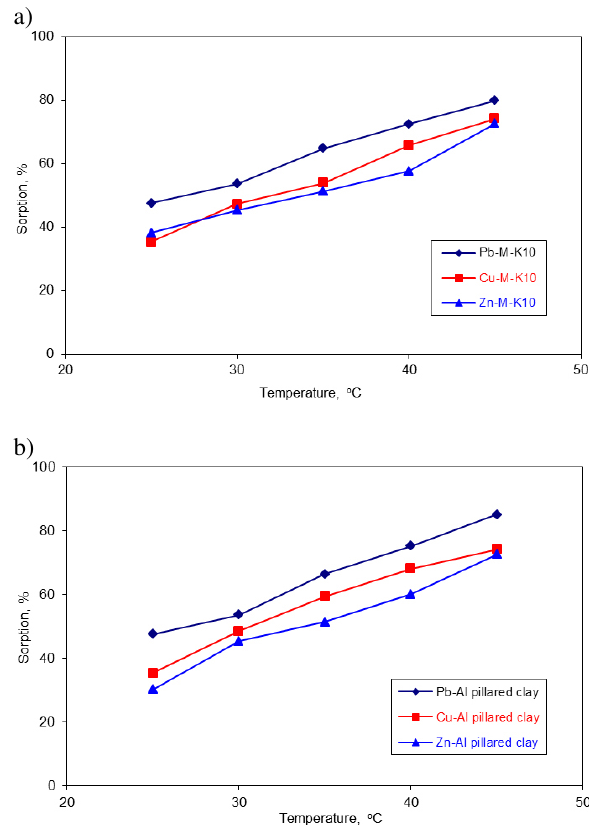
Fig. 5. Dependence of adsorption process on temperature: mont- morillonite- K10 (a) Al-pillared clay